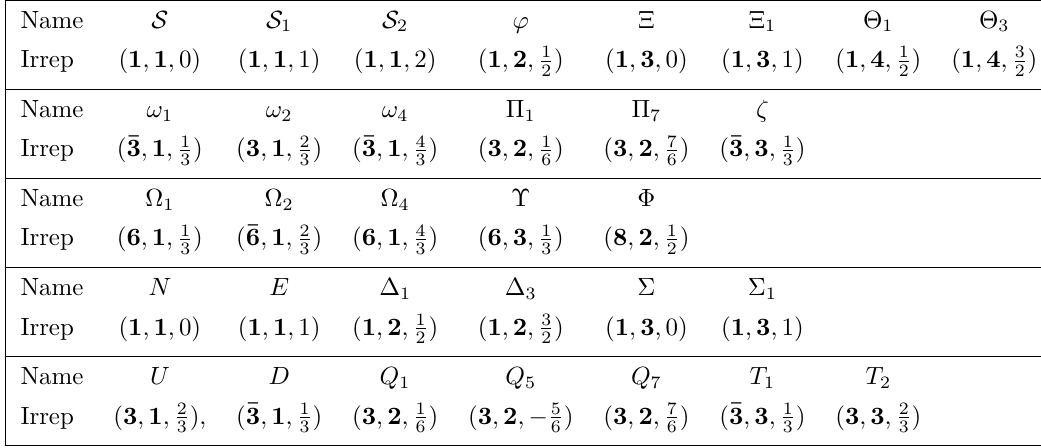
Table 2. The table shows the exotic scalars (top) and vectorlike or Majorana fermions (bottom) contributing to the dimension-six SMEFT at tree-level [38]. We sometimes use the label of a field as presented in the table to represent its conjugate, although we always define the transformation properties each time a field is mentioned to avoid confusion. For the leptoquarks (second row), we add a prime to the field name presented here if the baryon-number assignment is such that only the diquark couplings are